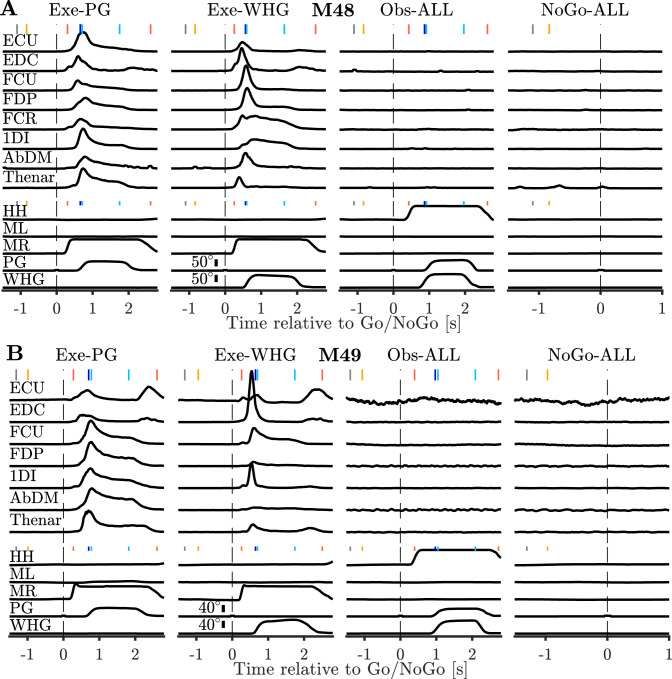
Example EMG traces during all conditions.(A) Example session normalized EMG, homepad, and displacement signals during execution, observation and NoGo. Execution traces are identical to those shown in Figure 2. Observation and NoGo EMG traces are averaged across both grasps, and plotted at 10x higher gain than execution. Vertical coloured markers denote median time of task events relative to Go or NoGo cues (vertical dashed lines), as in Figure 2. (B) Same as (A), but for M49.